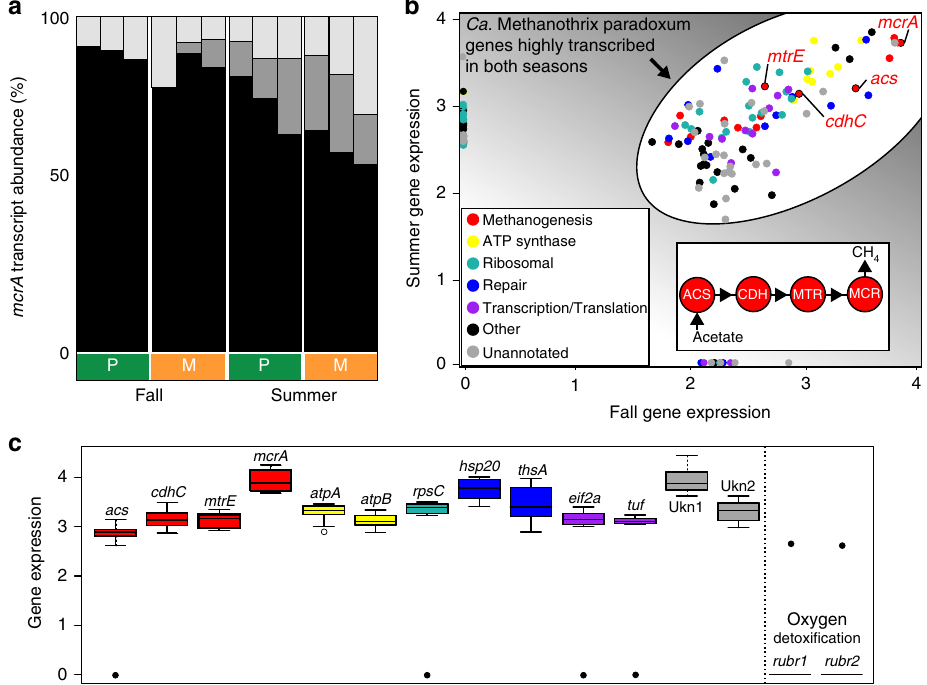
Fig. 3 Candidatus Methanothrix paradoxum genes transcribed in oxic soils. a Taxonomic assignment and relative abundance of mcrA transcripts in surface soils assigned to Candidatus Methanothrix paradoxum (black), Methanoregula (dark gray), and other methanogens (light gray). b The relationship between the 100 most transcribed genes (by log 10 FPKM) in each season, with gene functional categories denoted in color and key steps of the methanogenesis pathway highlighted. c Gene expression levels for selected genes from ( b ), across all samples with color legend used from ( b ) (black line, boxes, and whiskers represent the median, quartiles, and minimum/maximum of the log 10 FPKM values). For comparison, oxygen detoxi fi cation genes are not consistently transcribed at detectable